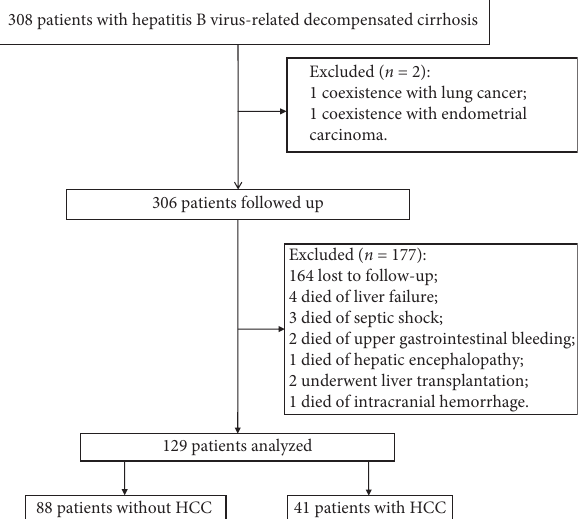
Figure 1: Screening of patients with hepatitis B virus-related decompensated cirrhosis. Table 1: Baseline characteristics of the patients with decompensated liver cirrhosis. Patients with HCC ( n �